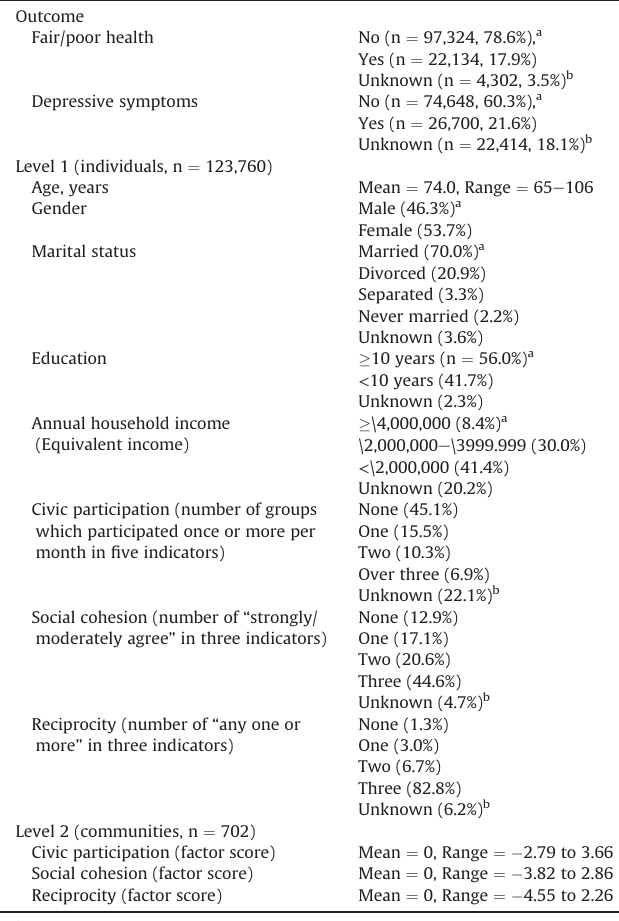
Table 4 Descriptive statistics of fi nal